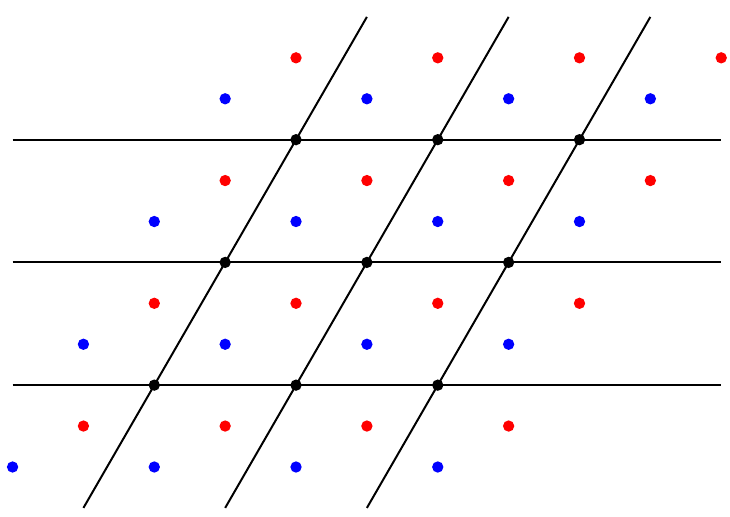
Figure 1 . The hexagonal lattice. The black points are z 1 = 0, the blue points are z 2 and the red points are z 3 . One can clearly see that there is an order 3 automorphism that rotates the picture around the